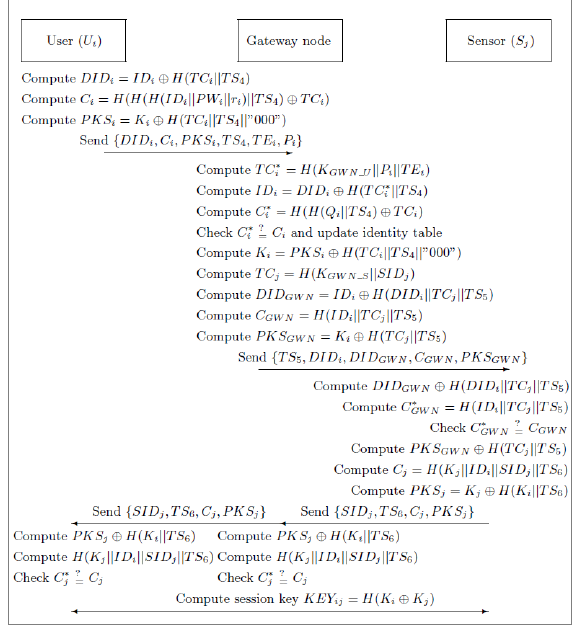
Figure 4. Illustration of the authentication and key agreement phase of our advanced